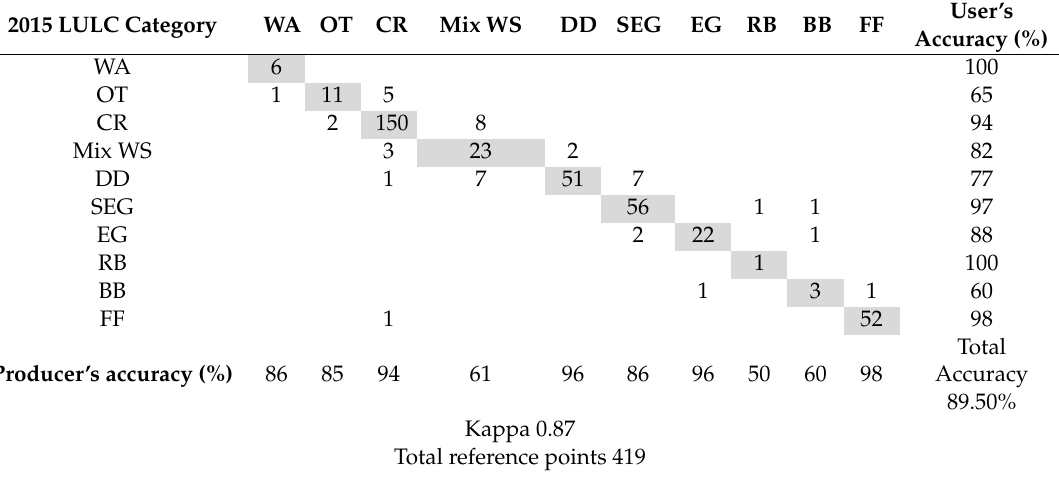
Table A6. Results of the accuracy assessment of the PBTC land cover map for 2015.